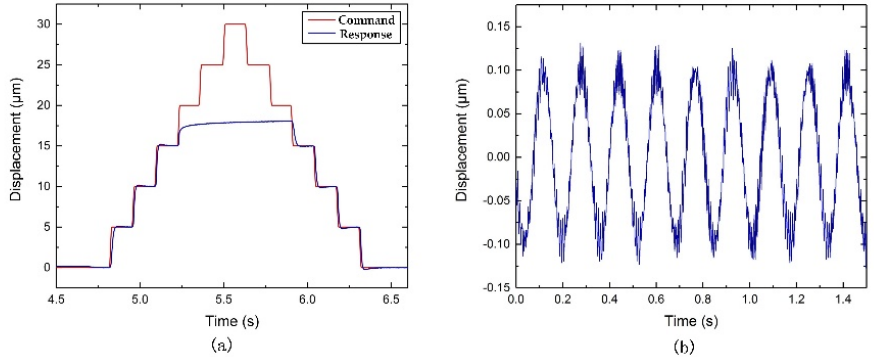
Figure 15. Experimental results of ( a ) motion stroke of the z-axis, ( b ) the coupling motion along the x-axis.